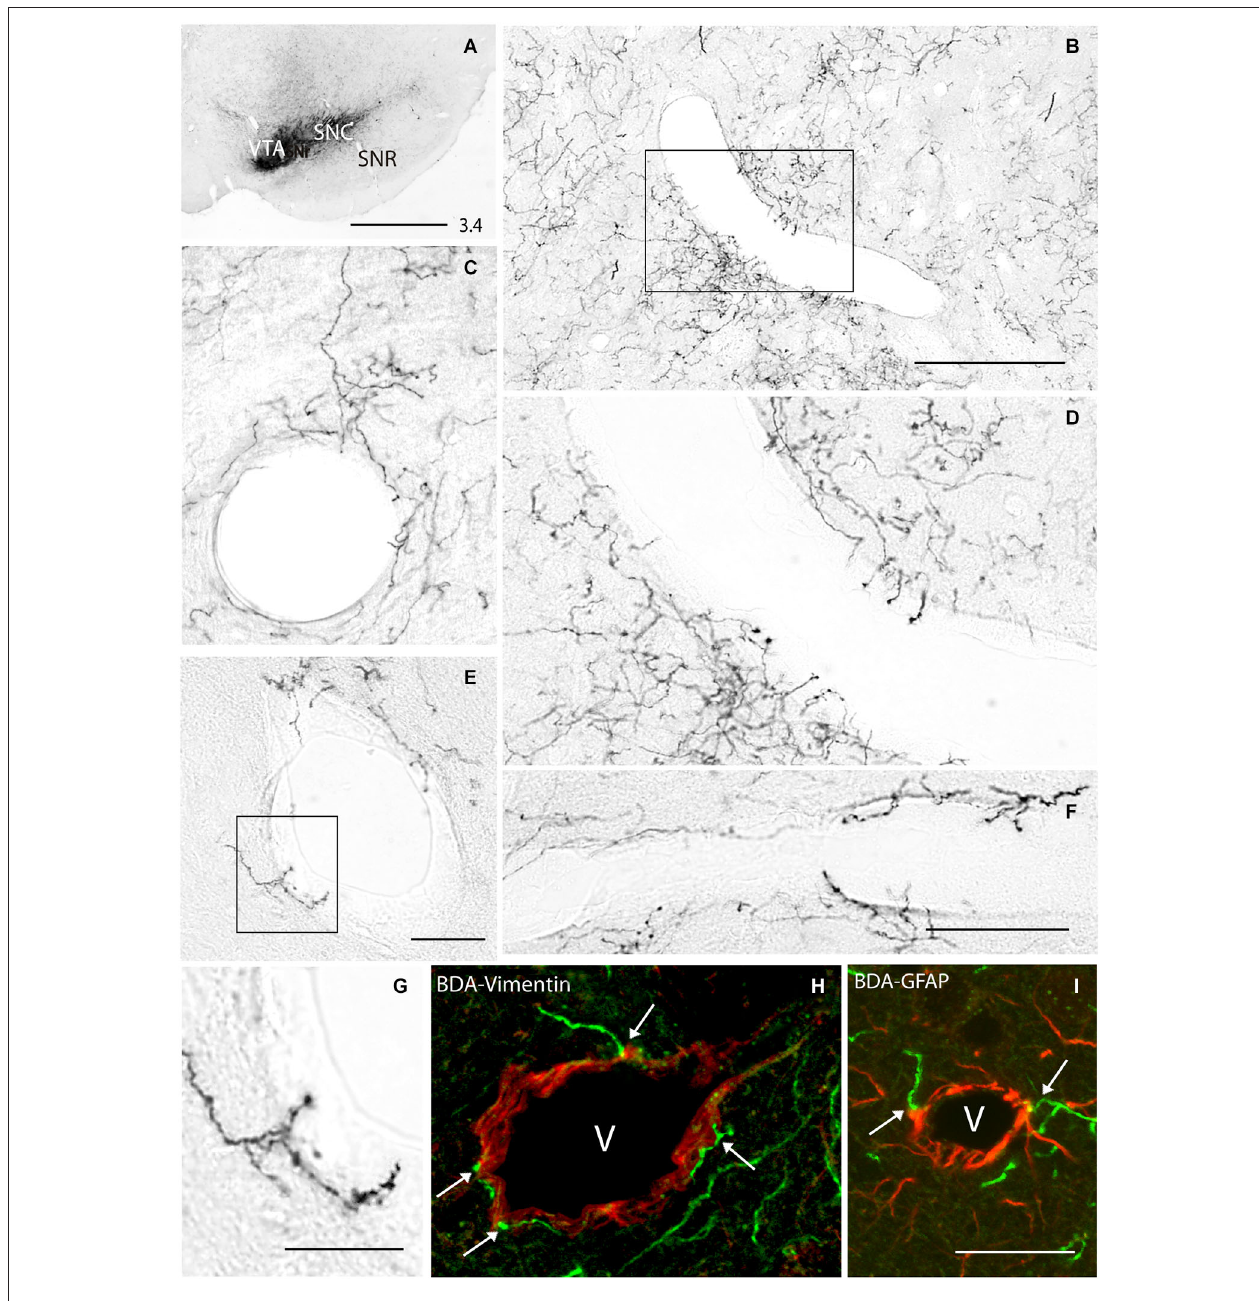
terminals abutted on striatal vessels and surrounding astrocytes (arrows in H and I ). (D,G) Boxed areas in (B) and (E) respectively. The number at the bottom right in (A) indicates the distance from the interaural axis in millimeters. SNR, substantia nigra pars reticulata. v, vessel lumen. Bar in (A) , 1 mm; in B, 400 µ m; in (F) (for D and F ), 150 µ m; in (G) , 100 µ m; in (I) (for H and I ), 100 µ m.